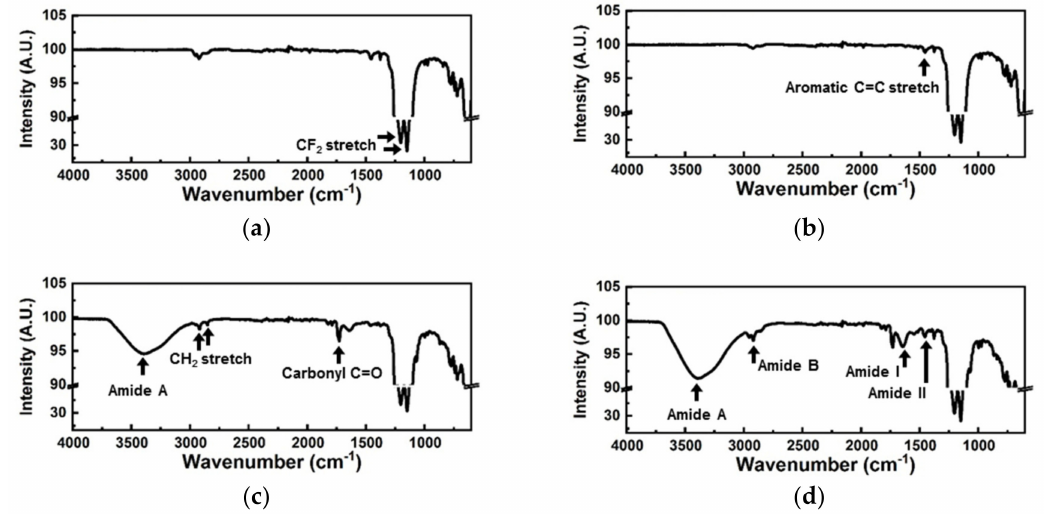
Figure4. Fourier-transforminfrared(FT-IR)spectraduringtheureaseimmobilizationprocess, wherethe ( a ) the PTFE membrane was sequentially treated with ( b ) parylene-A, ( c ) DSS and ( d )